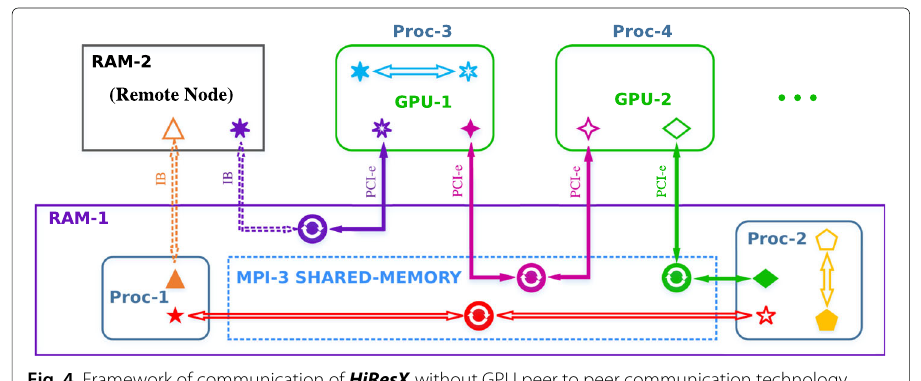
Fig. 4 Framework of communication of HiResX without GPU peer to peer communication technology support. For communication between processes that are all running on CPU, if processes are located in the same node, they exchange data within RAM with MPI-3 shared memory technique, see red path. If processes are located in different nodes, the standard MPI communication is utilized, see yellow path that connects triangle pair. For processes with GPU acceleration, data on GPU should be downloaded back to CPU, and then processes communicate in the same way as processes without